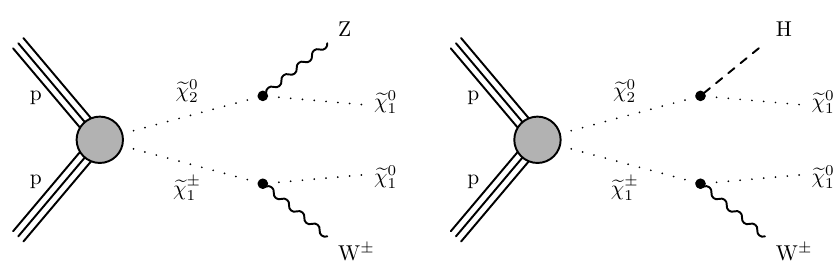
Figure 1 . Production of